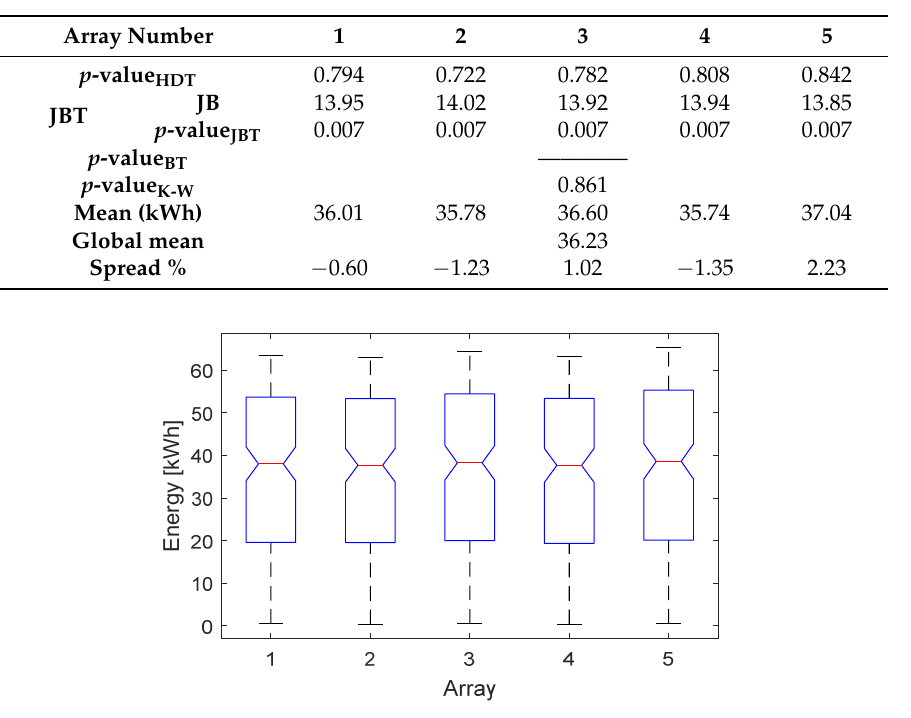
Figure 8. Box plot of K-W test of the five distributions for the six-months analysis (January–June).